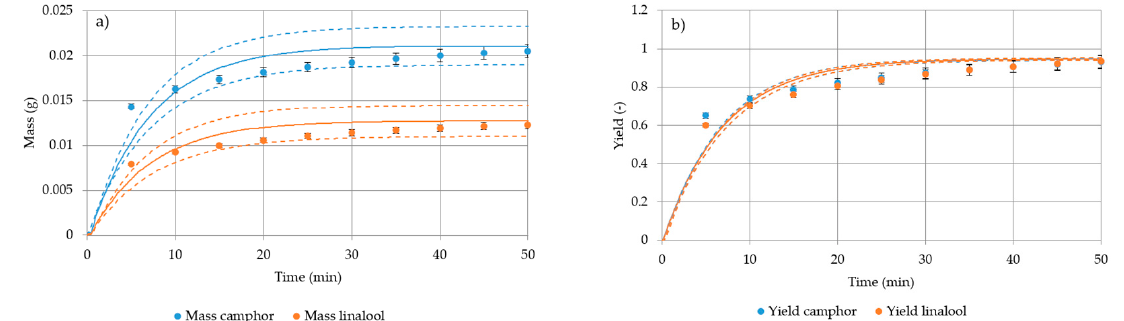
Figure 15. Precision and accuracy of the mass ( a ) and yield ( b ) of lavender.